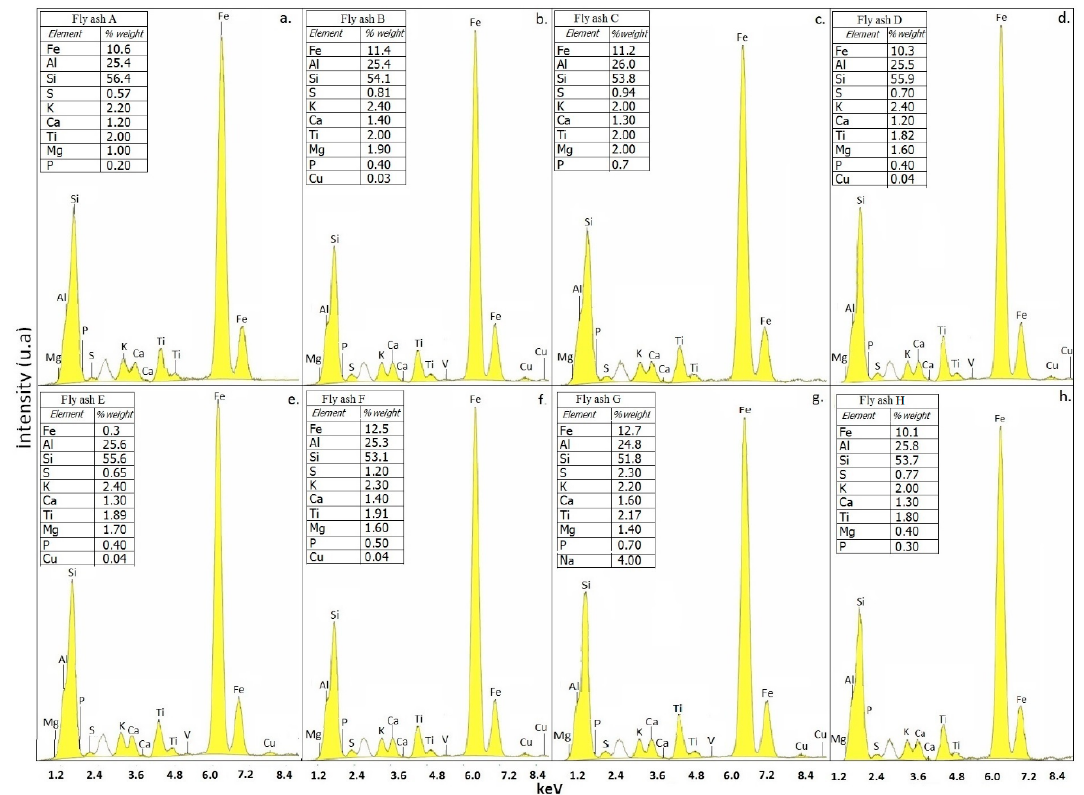
Figure 3. X-ray fluorescence analysis of precursor materials associated with ( a ) fly ash A, ( b ) fly ash B, ( c ) fly ash C, ( d ) fly ash D, ( e ) fly ash E, ( f ) fly ash F, ( g ) fly ash G, and ( h ) fly ash H.